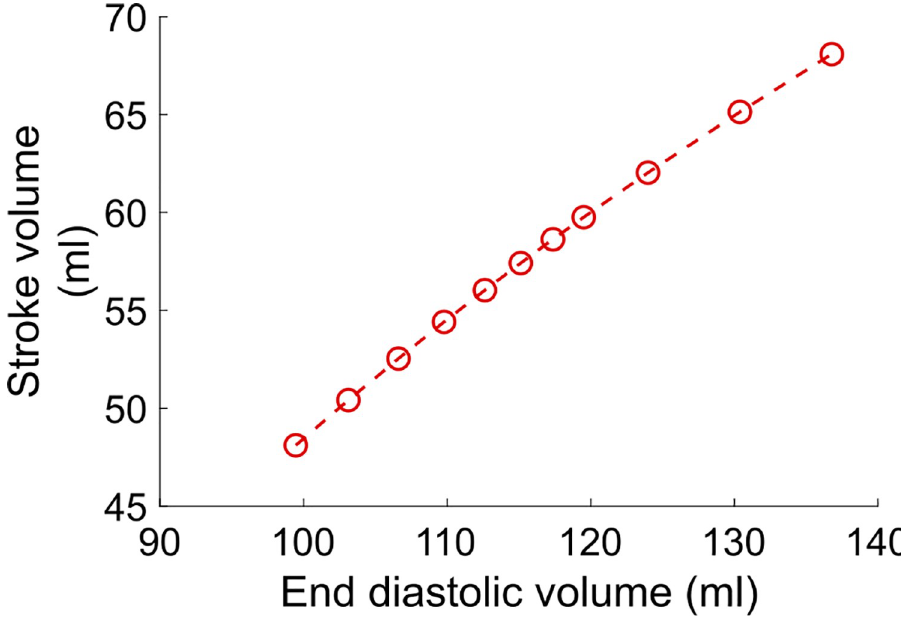
Fig 9. Frank-Starling curve obtained with the CVS